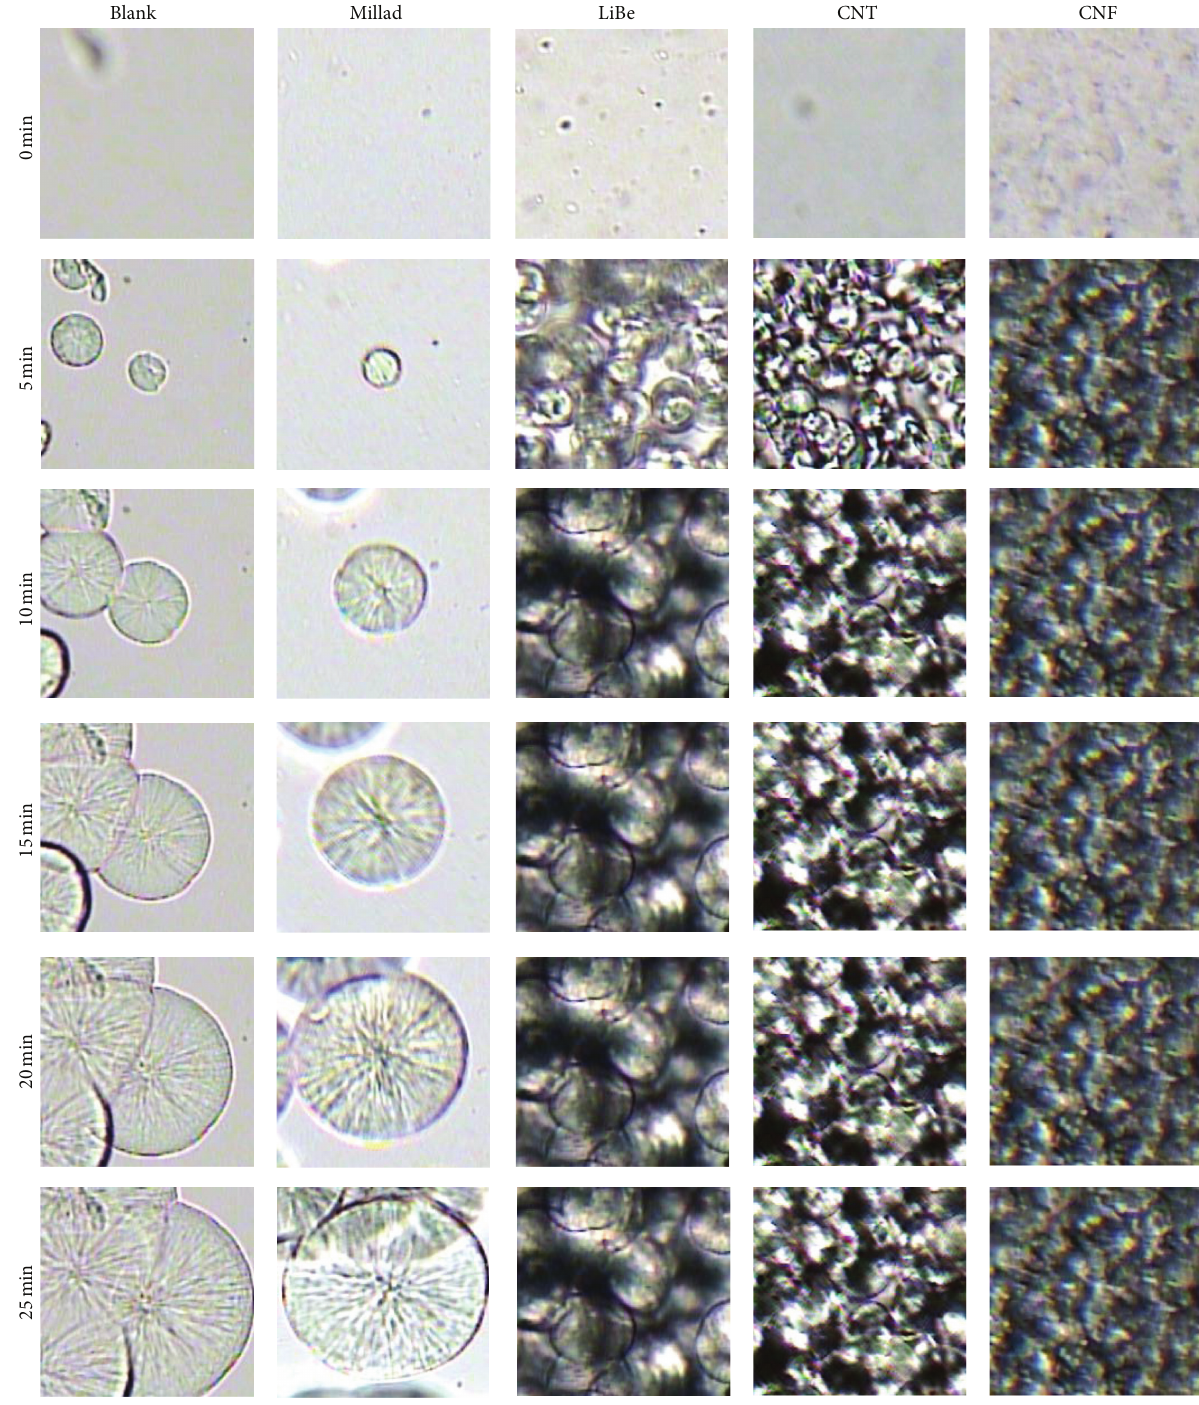
Figure 5: Crystallization process and crystal size of pure iPP and nucleated iPP composites at 135 ∘ C, with 0.01wt% of nucleating agent.